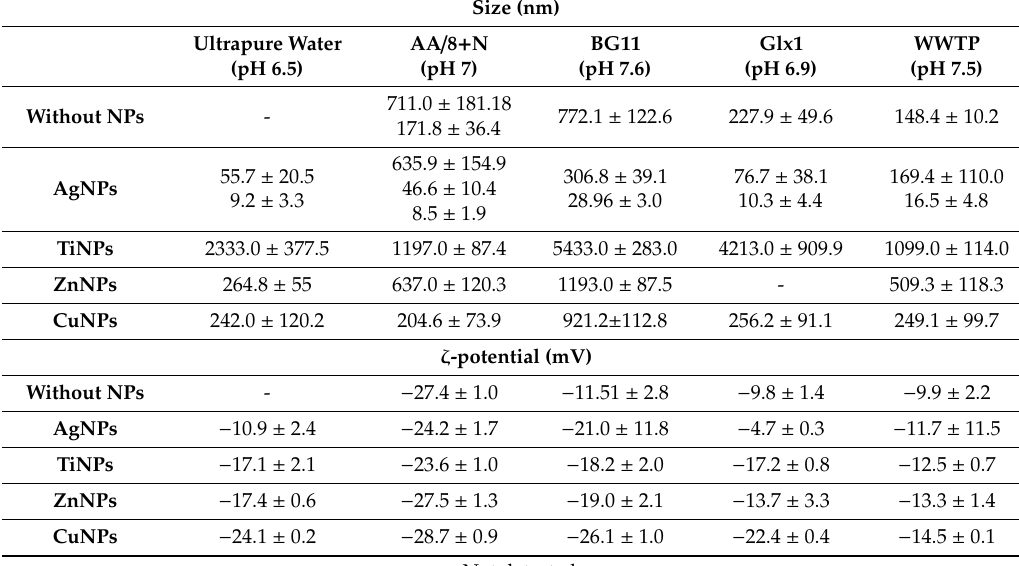
Table 2. Particle hydrodynamic size determined by dynamic light scattering and ζ -potential measured by electrophoretic light scattering in ultrapure water, AA / 8 + N and BG11 culture media and real water matrices (Glx1 and